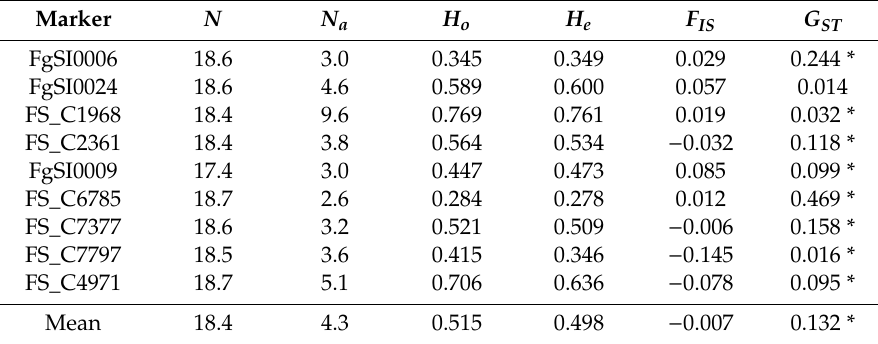
Table 2. Mean genetic diversity indices over all populations for each marker. Marker N N a H o H e F